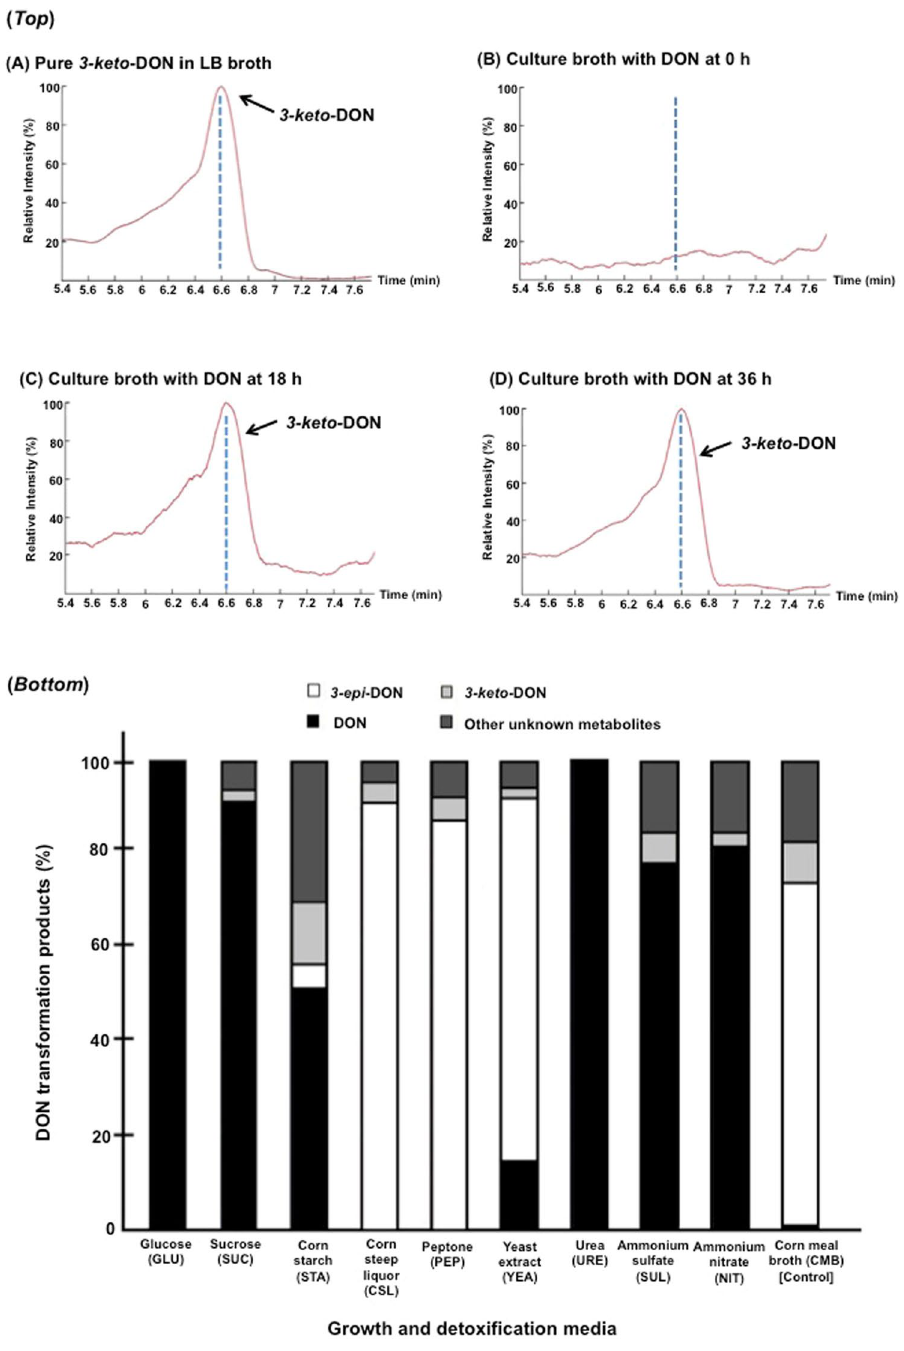
Figure 4. The detection of 3-keto- DON in Devosia mutans 17-2-E-8 bacterial cultures and 3-keto- DON and 3-epi- DON concurrence during Devosia mutans 17-2-E-8 assisted-epimerisation of DON. ( Top ): The chromatographic separation of 3-keto- DON obtained from depleted cultures of Devosia mutans 17-2-E-8 at 0 h, 18 h, and 36 h ( panel B , C , and D ) in comparison to 3-keto- DON standard that was chemically synthesized ( panel A ). The analysis was conducted using LC-MS/MS by monitoring mass transition m/z 294.9 > 247.1 as described in the Materials and Methods section. ( Bottom ): Different media preparations containing: glucose, sucrose and corn starch (carbon sources); corn steep liquor, peptone, yeast extract, and urea (organic nitrogen sources); ammonium sulfate and ammonium nitrate (inorganic nitrogen sources) were tested for DON epimerization. Every broth that supported DON epimerization showed the concurrence of 3-keto- DON at the same time. While experiments were conducted in triplicates to confirm the observed tendencies, no quantitative statistical inferences between different broths are